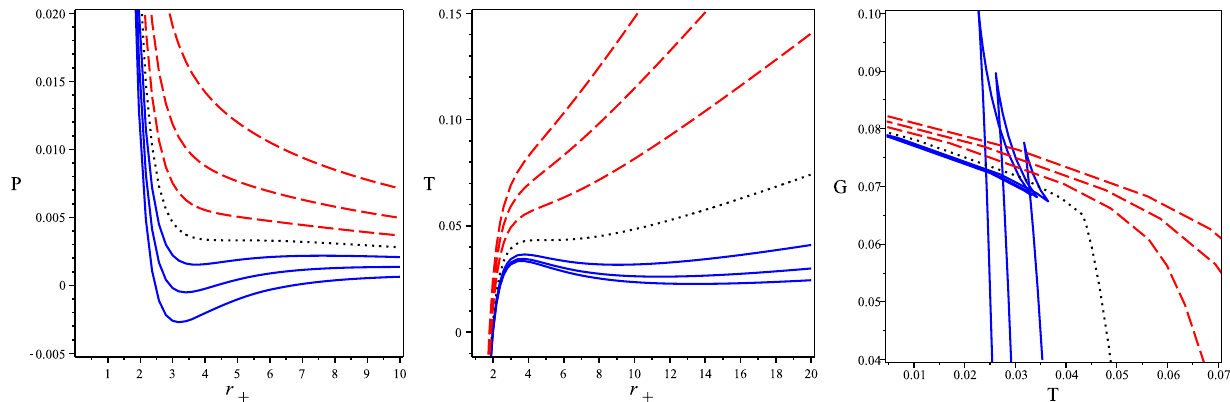
Middle and right panels: P < P c (continuous lines), P = P c (dotted lines) and P > P c (dashed